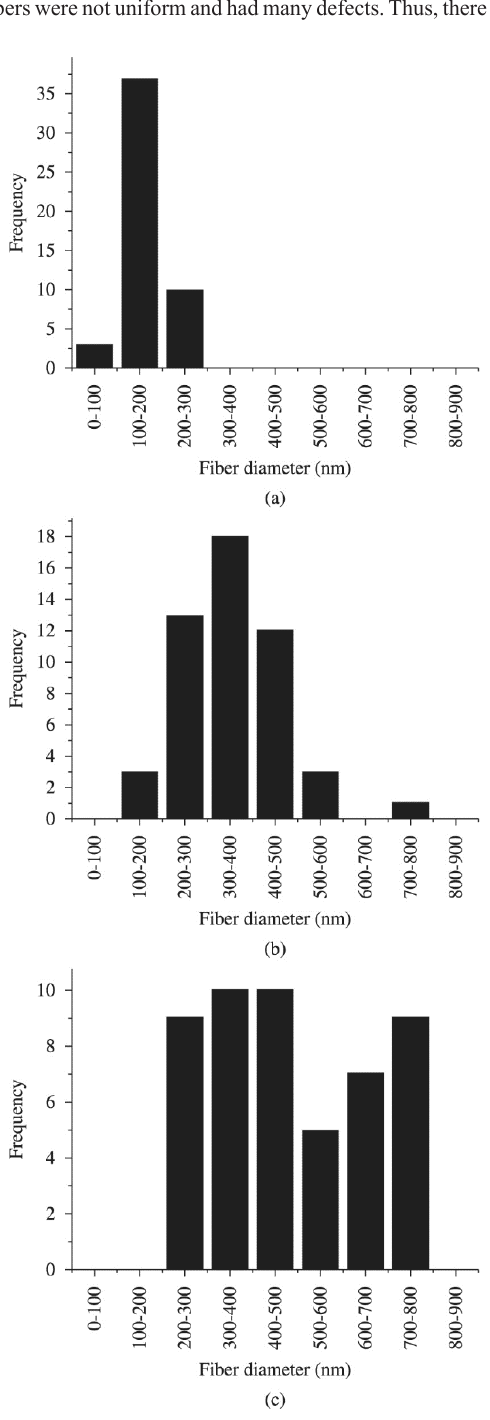
Figure 10. Histogram of fiber diameters of gelatin / PVP eletrofiadas. With different concentrations of acetic acid (%) weight: (a) Solution 4 (37.0), (b) Solution 6 (46.3), (c) Solution 7 (64.8). Figure 11. Electrospun gelatin/PVP